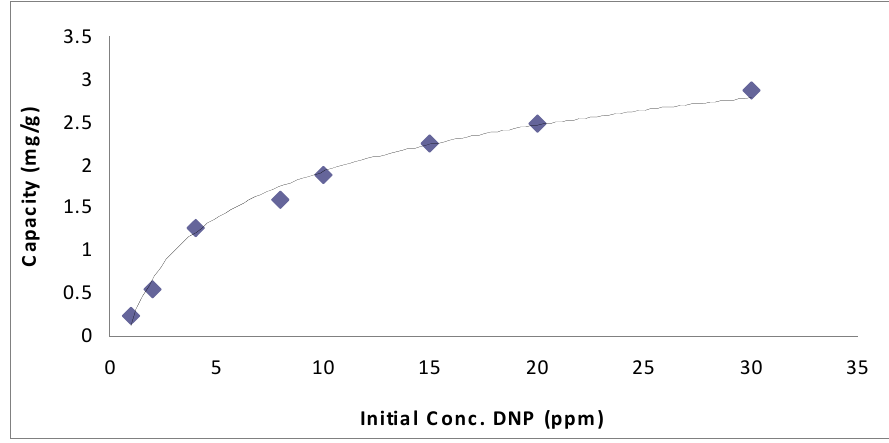
Figure 8. Adsorption capacity of various concentration of 2,4-dinitrophenol by